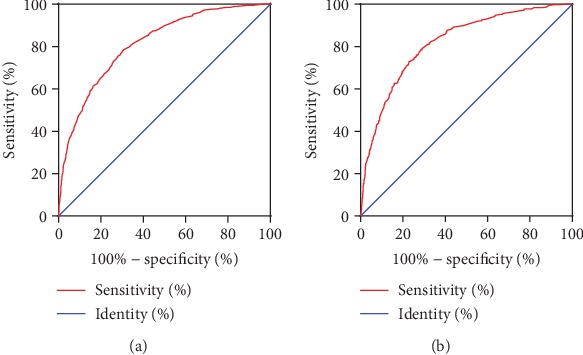
Area under the ROC of the nomogram in (a) the primary cohort and (b) the validation cohort.